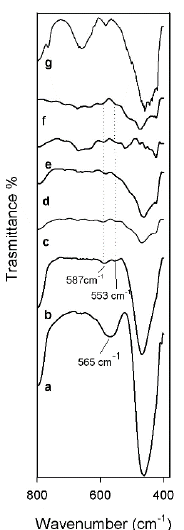
Figure 9. FT-IR spectra of ( a ) pure SiO 2 not soaked in SBF; ( b ) pure SiO 2 ; ( c ) SiO 2 /ZrO 2 (20 wt.%); ( d ) SiO 2 /ZrO 2 (33 wt.%); ( e ) SiO 2 /ZrO 2 (50 wt.%); ( f ) pure ZrO 2 after 21 days in SBF; ( g ) SiO 2 /ZrO 2 (50 wt.%), not soaked in SBF .